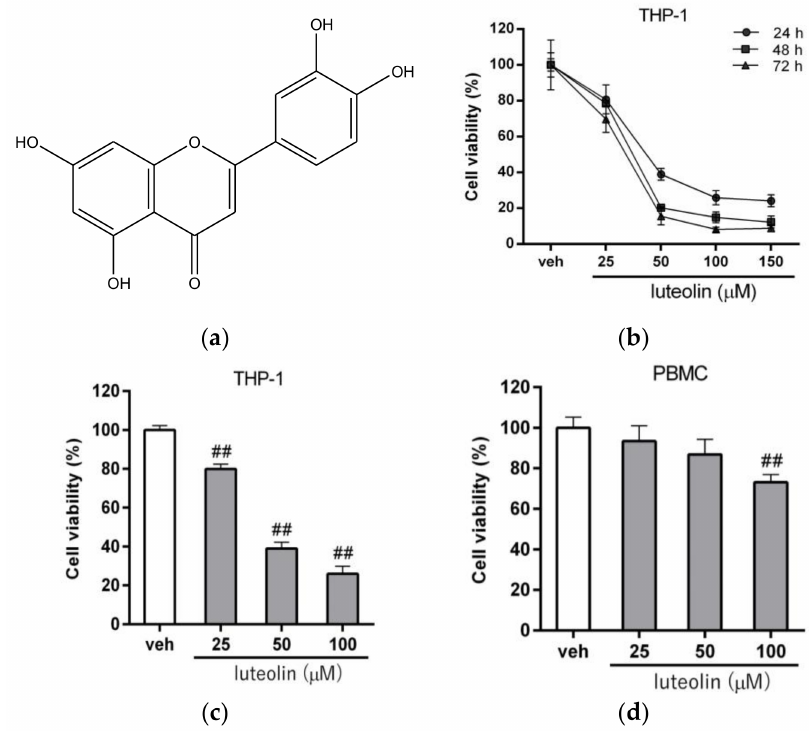
Figure 1. Effects of luteolin on the viability of human myeloid leukemia cells. ( a ) Chemical structure of luteolin. ( b ) THP-1 cells were treated with vehicle (0.1% dimethyl sulfoxide (DMSO)) or luteolin (25, 50, 100 and 150 µ M) for 24 h, 48 h and 72 h, respectively. Cell viability was measured by MTT assay. The data are presented as the means ± standard deviation (SD) from three independent experiments. THP-1 cells ( c ) and peripheral blood mononuclear cells (PBMCs) ( d ) were treated with vehicle or luteolin (25, 50 and 100 µ M) for 24 h, and cell viability was determined by MTT assay. The data are presented as the means ± SD from three independent experiments. ## p < 0.01 represents a significant difference compared to the vehicle-treated cells